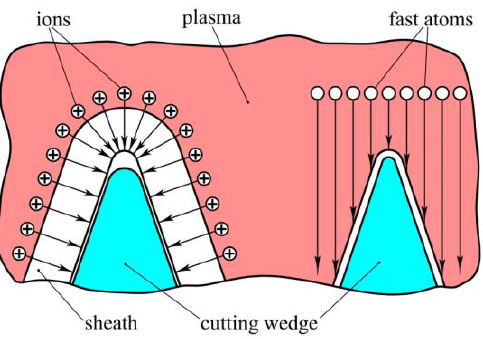
Figure 14. Scheme of etching cutting tools in plasma by accelerated particles.